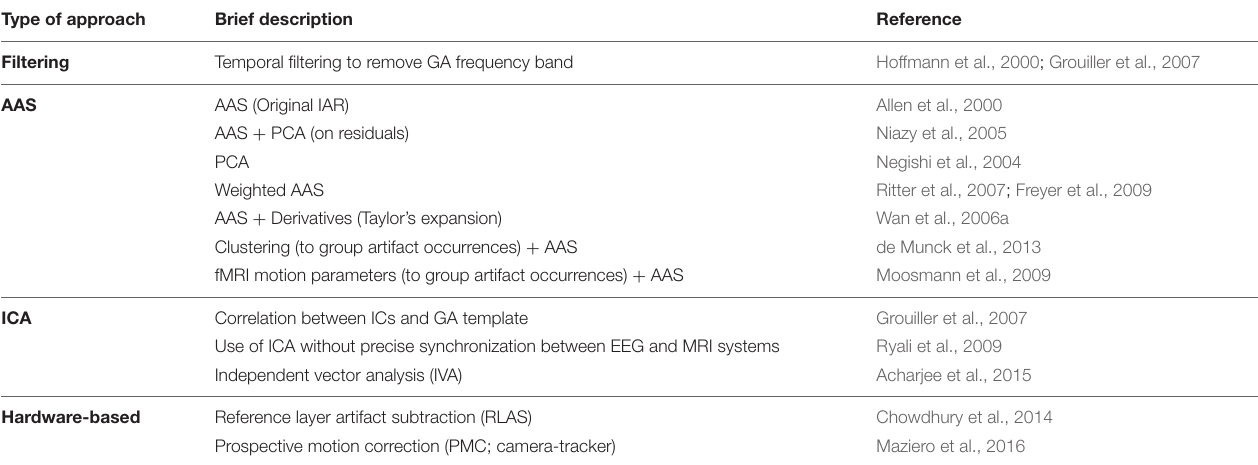
TABLE 1 | List of GA correction methods. These methods can be roughly divided into four main approaches: filtering, AAS-based (AAS and its several variations), ICA-based (as well as IVA, an extension of ICA to multiple datasets) and